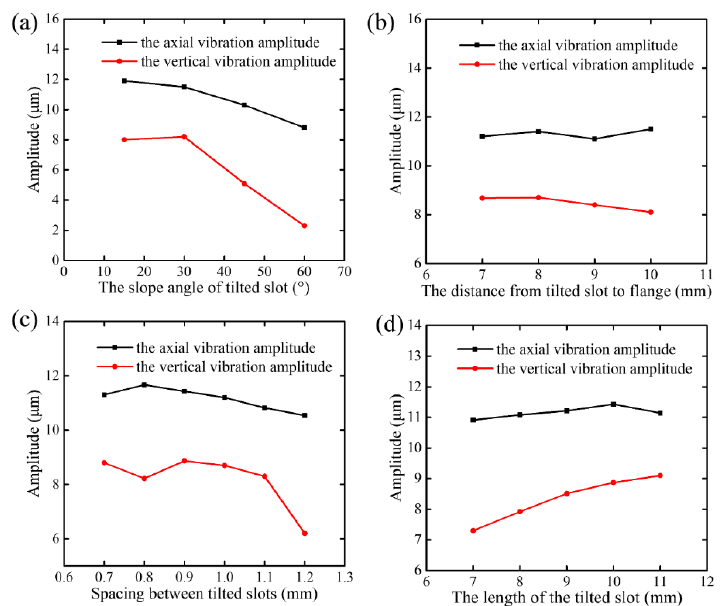
Figure 4. The effects of tilted slot parameters on vibration amplitudes of axial and vertical directions. ( a ) Effects of the slope of tilted slot on vibration amplitudes ( a = 10 mm, b = 1.0 mm, L C = 10 mm). ( b ) Effects of the distance from tilted slot to flange on vibration amplitudes ( a = 10 mm, b = 1.0 mm, β = 30°). ( c ) Effects of the spacing of the tilted slots on vibration amplitudes ( a = 10 mm, L C = 8 mm, β = 30°). ( d ) Effects of the length of tilted slot on vibration amplitudes ( b = 0.9 mm, L C = 8 mm, β = 30°).